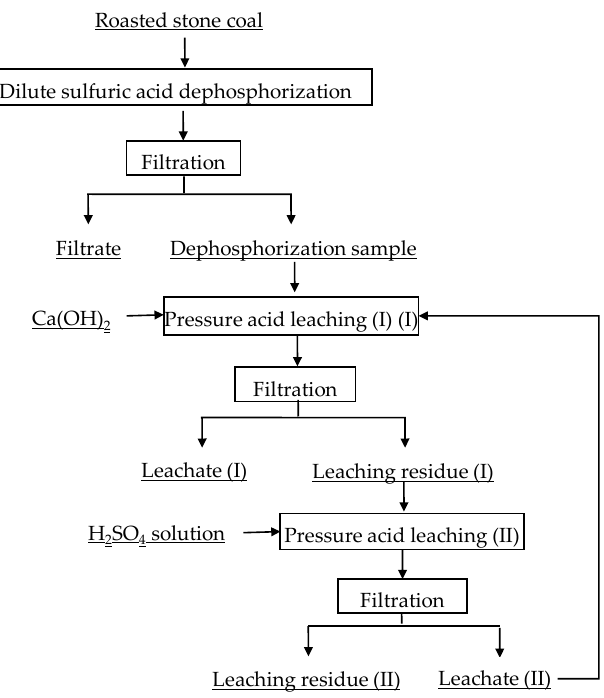
Figure 3. Flow sheet of the dilute sulfuric acid dephosphorization (DSAD)-two-stage pressure acid leaching (PAL) process.